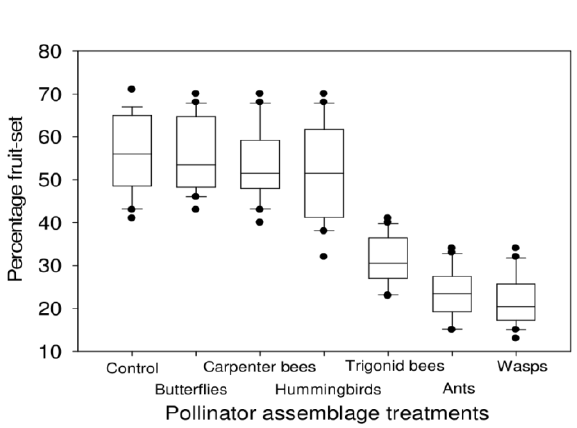
F IGURE 1. Pollinator taxa and effectiveness of visits on the percentage of fruit set in Lantana camara. The Control variable consists of the effects of all pollinating taxa visits on fruit set. Butterflies, Carpenter bees and Hummingbirds were found to be more effective pollinators than Trigonid bees, ants and